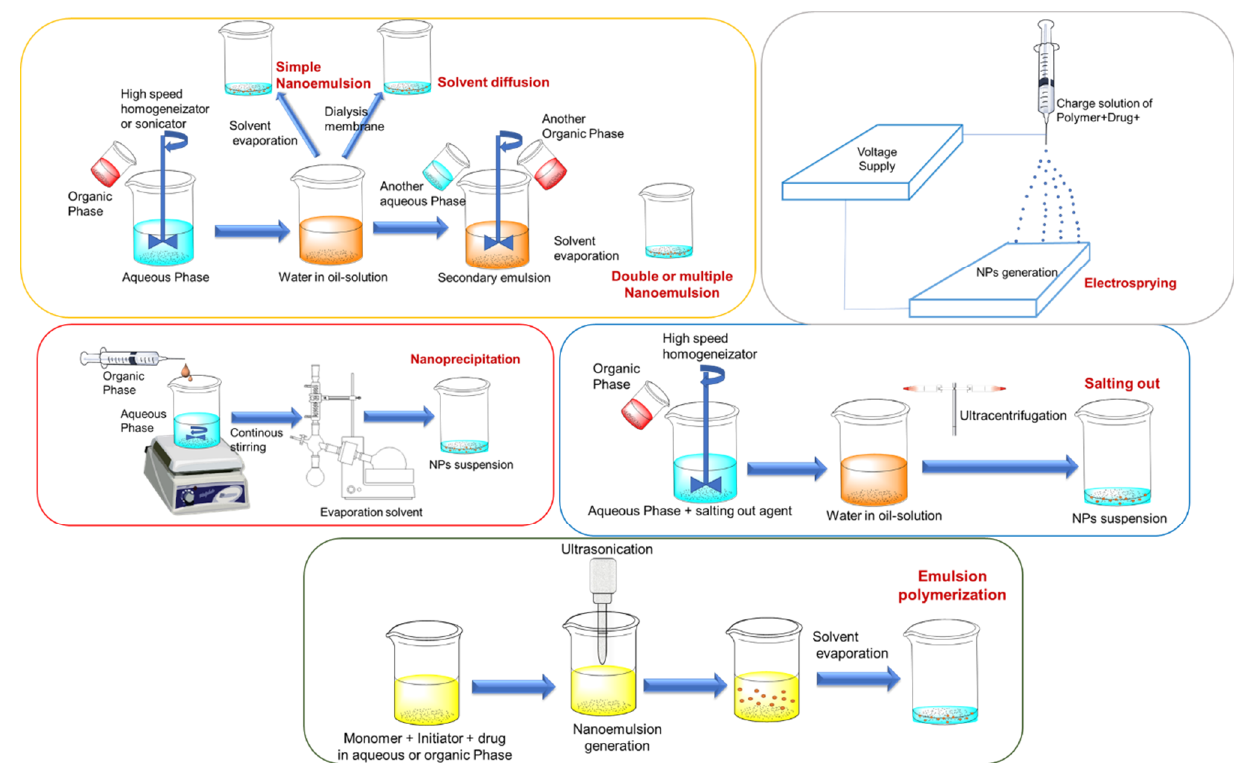
Figure 7. Illustration of the formulation of polymeric NPs by the most significative methods. Emulsion polymerization is a bottom-up methodology, whereas nanoprecipitation, simple nano-emulsion, solvent diffusion, double or multiple nano-emulsion, and salting out are top-down methodologies.